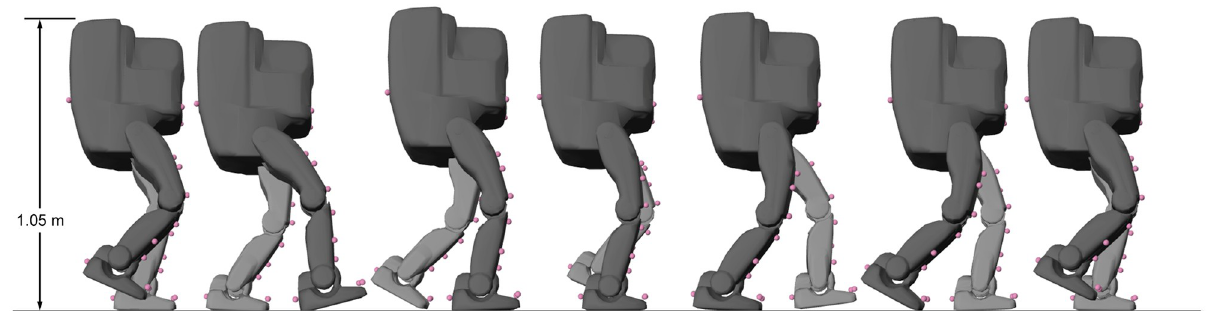
Fig 1. OpenSim model of a humanoid robot during gait. Model markers (pink spheres) track the measured trajectories of experimental markers (not shown) to produce a simulation of the robot’s motion. Step length is 0.33 m.